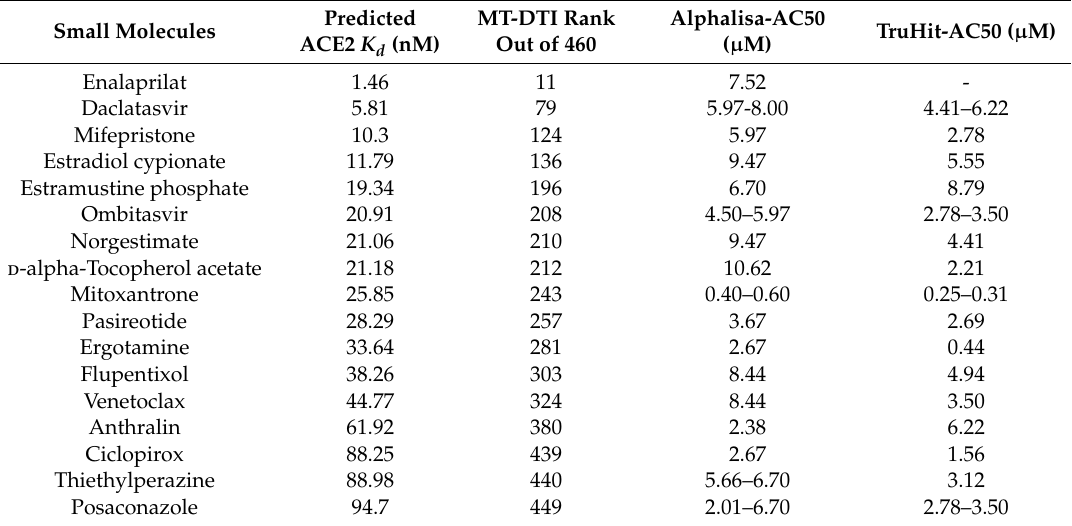
Table 2. The list of drugs those may a ff ect protein–protein interaction between ACE2 and SARS-CoV-2 S protein with ACE2 K d < 100 nM and comparison to AlphaLISA and TruHit proximity assay results provided by NCATS OpenData